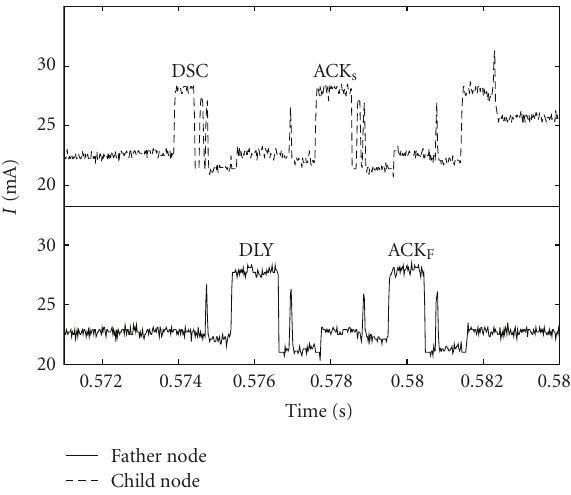
Figure 5: Mean tree depth for Case C and Case D. Figure 6: AAO in real implementation using